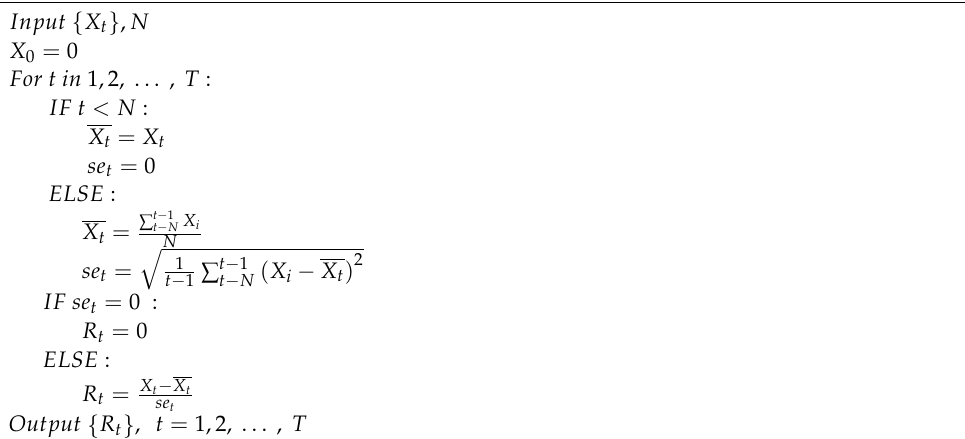
Algorithm 1 Moving z-score with window size n (MZ_n)